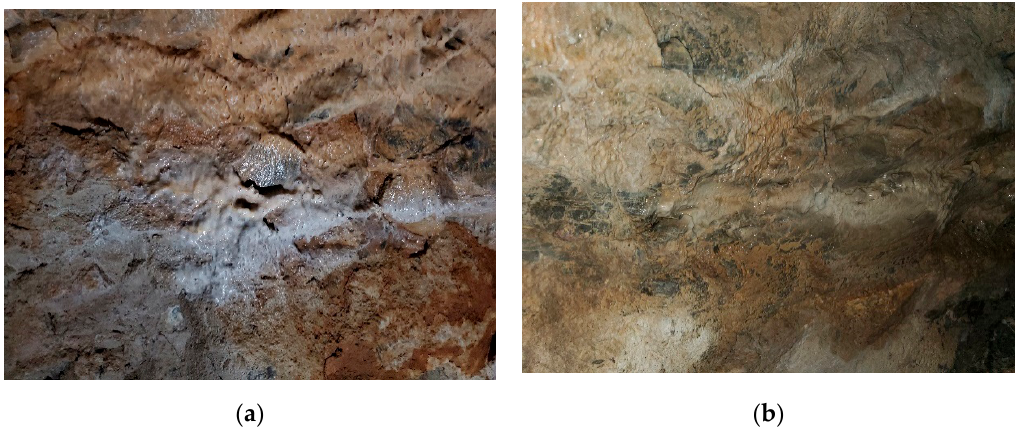
Figure 3. Cavern karst phenomena: ( a ) calcium crystal precipitation and ( b ) cavern wall dripping.